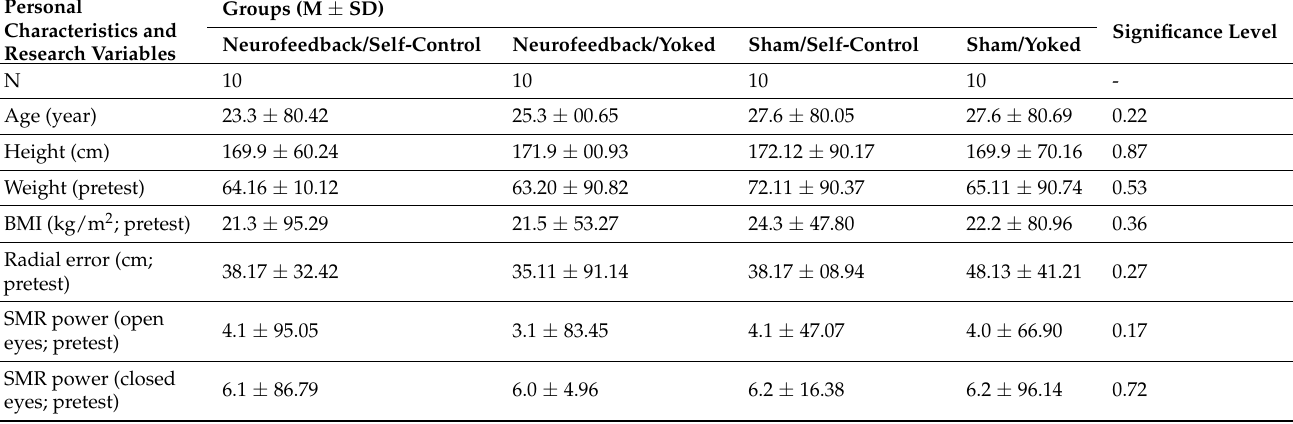
Table 1. Participant characteristics and research